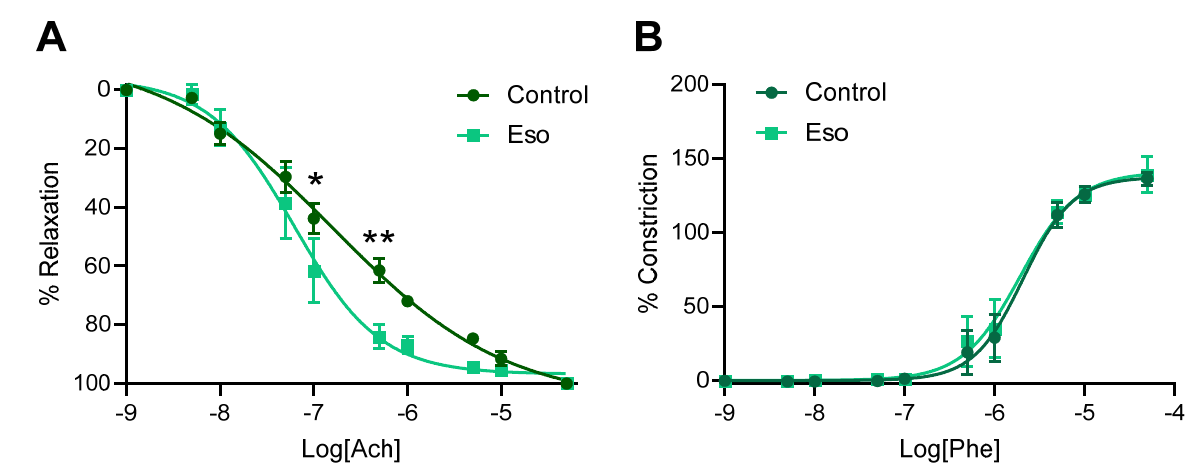
Figure 7. Effect of esomeprazole administration throughout pregnancy on vascular reactivity of mesenteric arteries collected from obese mice receiving L-NAME. Mesenteric artery ( A ) vasodilation to acetylcholine (Ach) and ( B ) constriction to phenylephrine (Phe) was assessed via wire myography (ex vivo). Arteries collected from the obese L-NAME mice given esomeprazole relaxed significantly more in response to 10 − 7 and 10 − 6.5 M doses of acetylcholine ( A ) compared to arteries collected from control (vehicle treated) mice. Arteries did not show altered vasoconstriction in response to phe- nylephrine compared to the arteries from control mice ( B ). Data points presented as mean ± SEM, and curves fitted with a non-linear regression (log(agonist) vs. response–variable slope (four parameters)). n = arteries from 4–6 mice/group. * p < 0.05, ** p < 0.01.